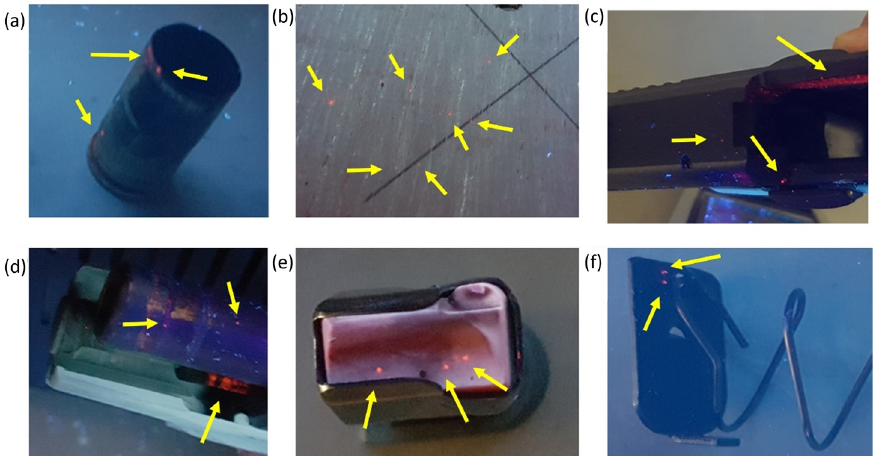
Figure 9. Red residual luminescent in GSR: ( a ) in the ejected capsule; ( b ) in the triggered cartridge; ( c ) inside the bolt of the firearm; ( d ) inside the slide of the firearm; ( e ) over the magazine and ( f ) under the magazine. UV light irradiation, λ = 254 nm.